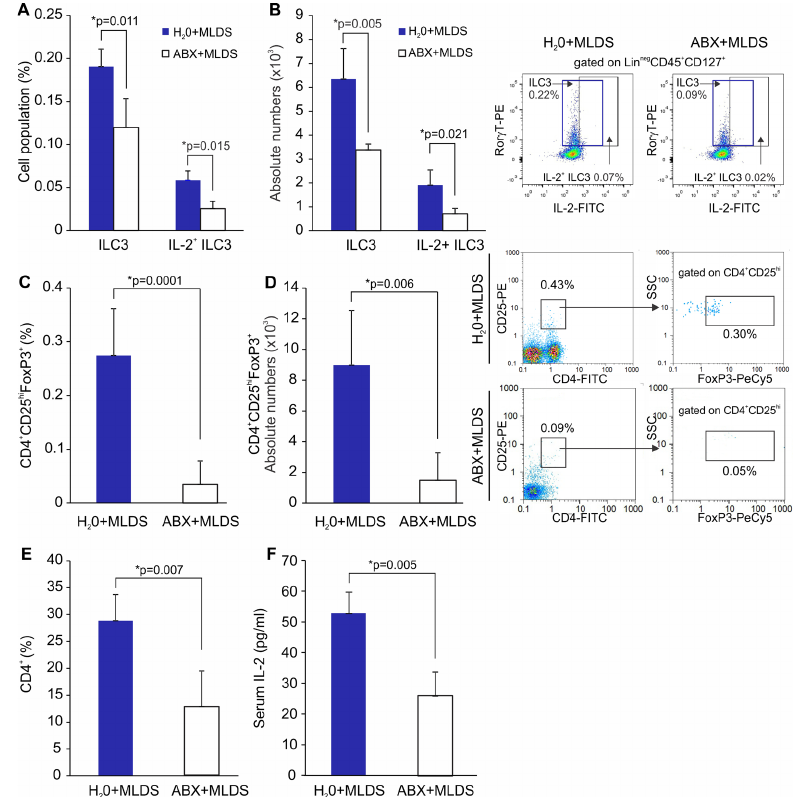
Figure 7. Accelerated MLDS - induced diabetes in antibiotics (ABX) - treated mice coincides with a decrease in IL−2 - producing ILC3 and Treg in the SILP of C57BL/6 mice. The percentages and absolute numbers of Lin neg CD45 + CD127 + RORγt + ILC3 and IL−2 - producing ILC3 ( A , B ), CD4 + CD25 hi FoxP3 + Treg ( C , D ) and CD4 + ( E ) in the SILP of MLDS - induced diabetic C57BL/6 mice orally treated with ABX or H 2 O. IL−2 concentration in the sera of MLDS - induced diabetic C57BL/6 mice orally treated with ABX or H 2 O ( F ). Number of mice per group was 5. * p < 0.05 was considered as statistically significant when samples from ABX+MLDS - treated and H 2 O+MLDS - treated mice were compared.